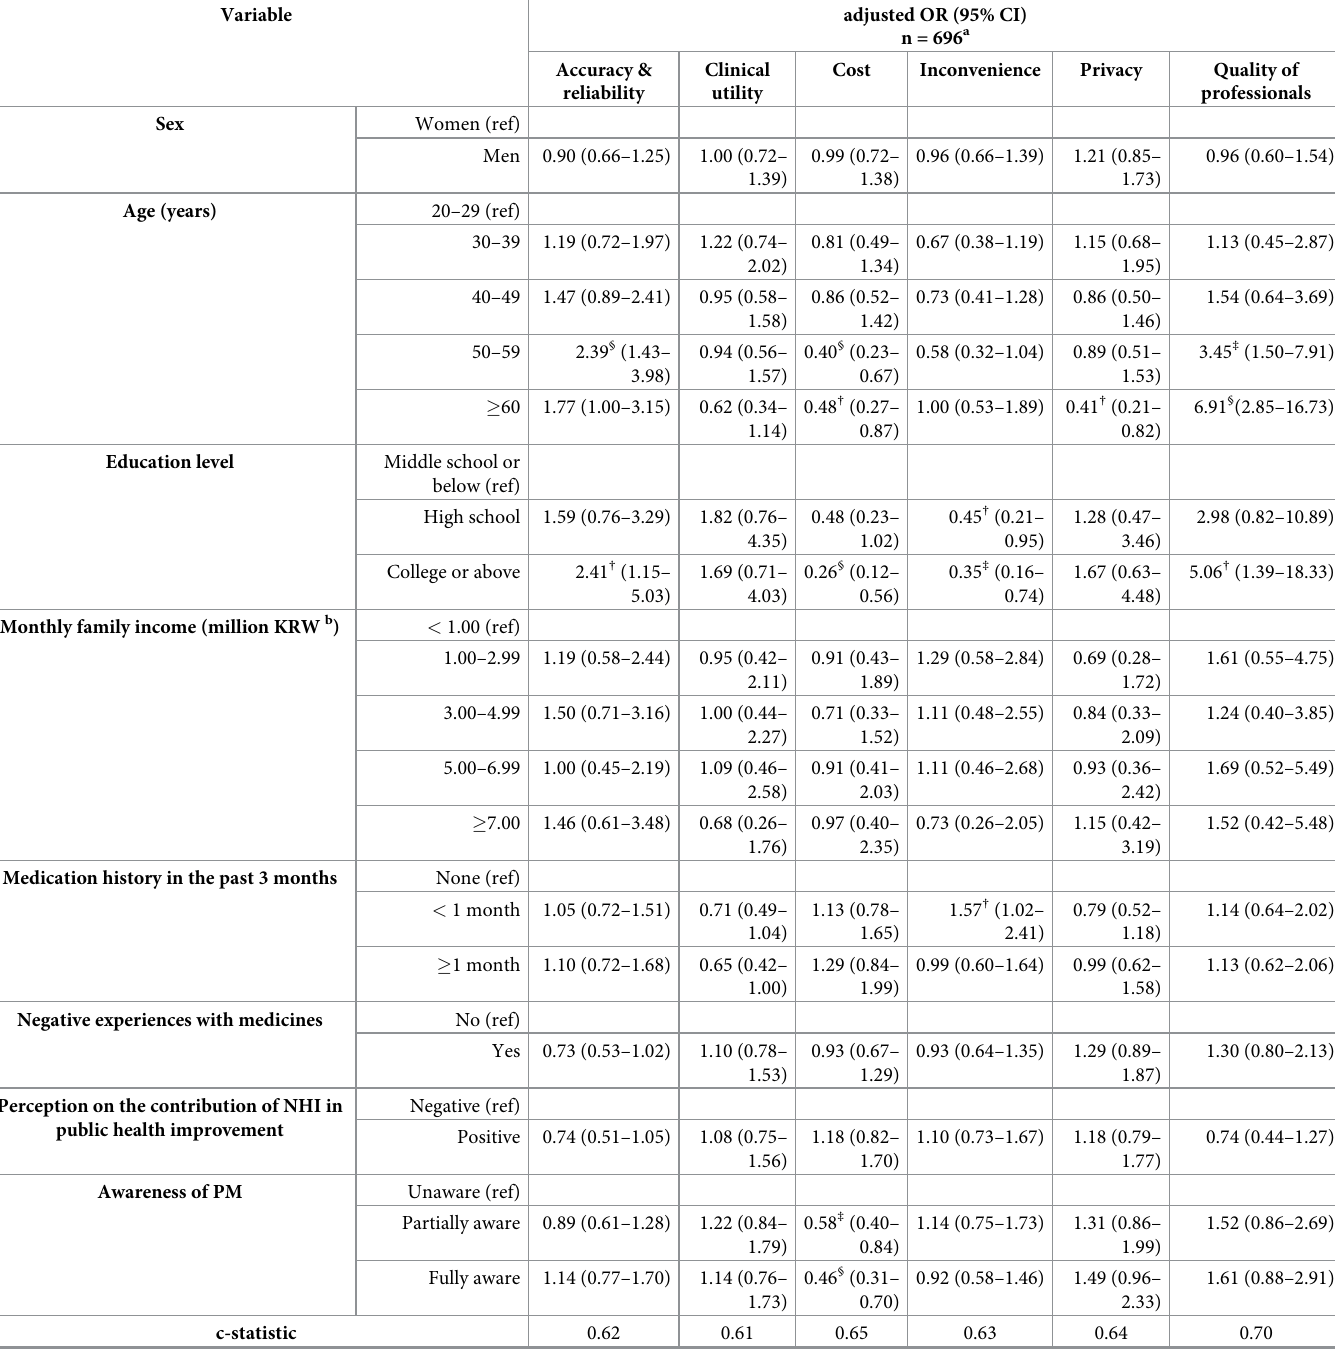
Table 5. Multivariate logistic regression analysis results for factors that are associated with public concerns about clinical application of pharmacogenomic testing in